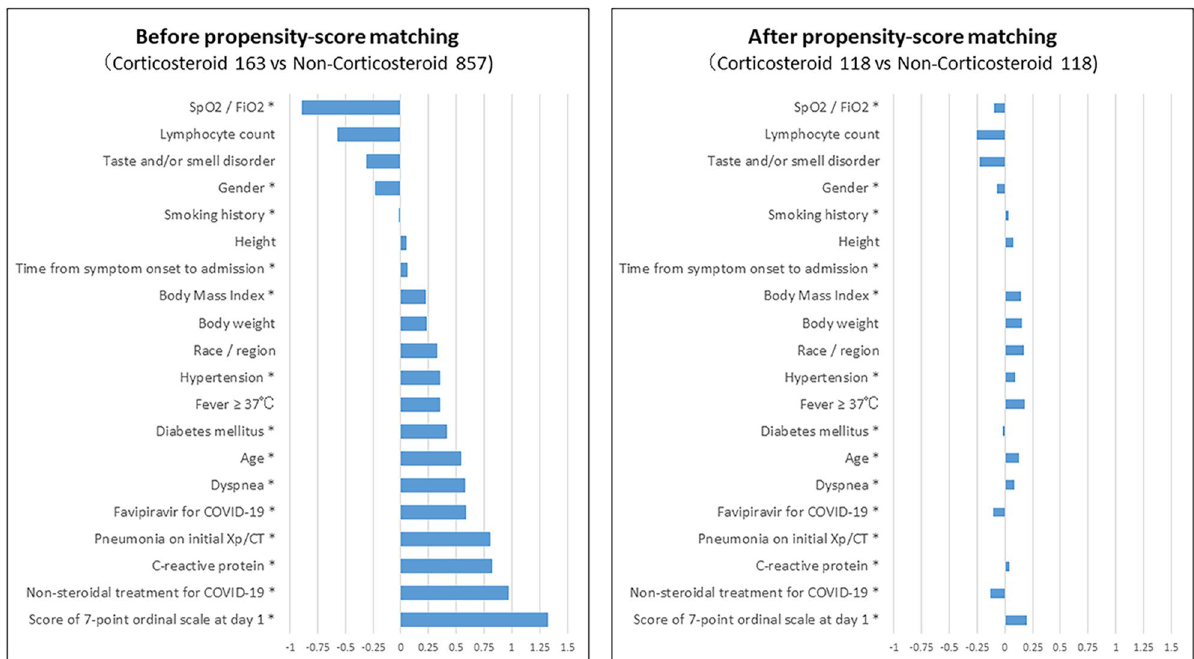
Figure 2. Standardized Mean Difference Before and After Propensity Score Matching. * Covariates used for propensity score matching. COVID-19, coronavirus disease 2019; CT, computed